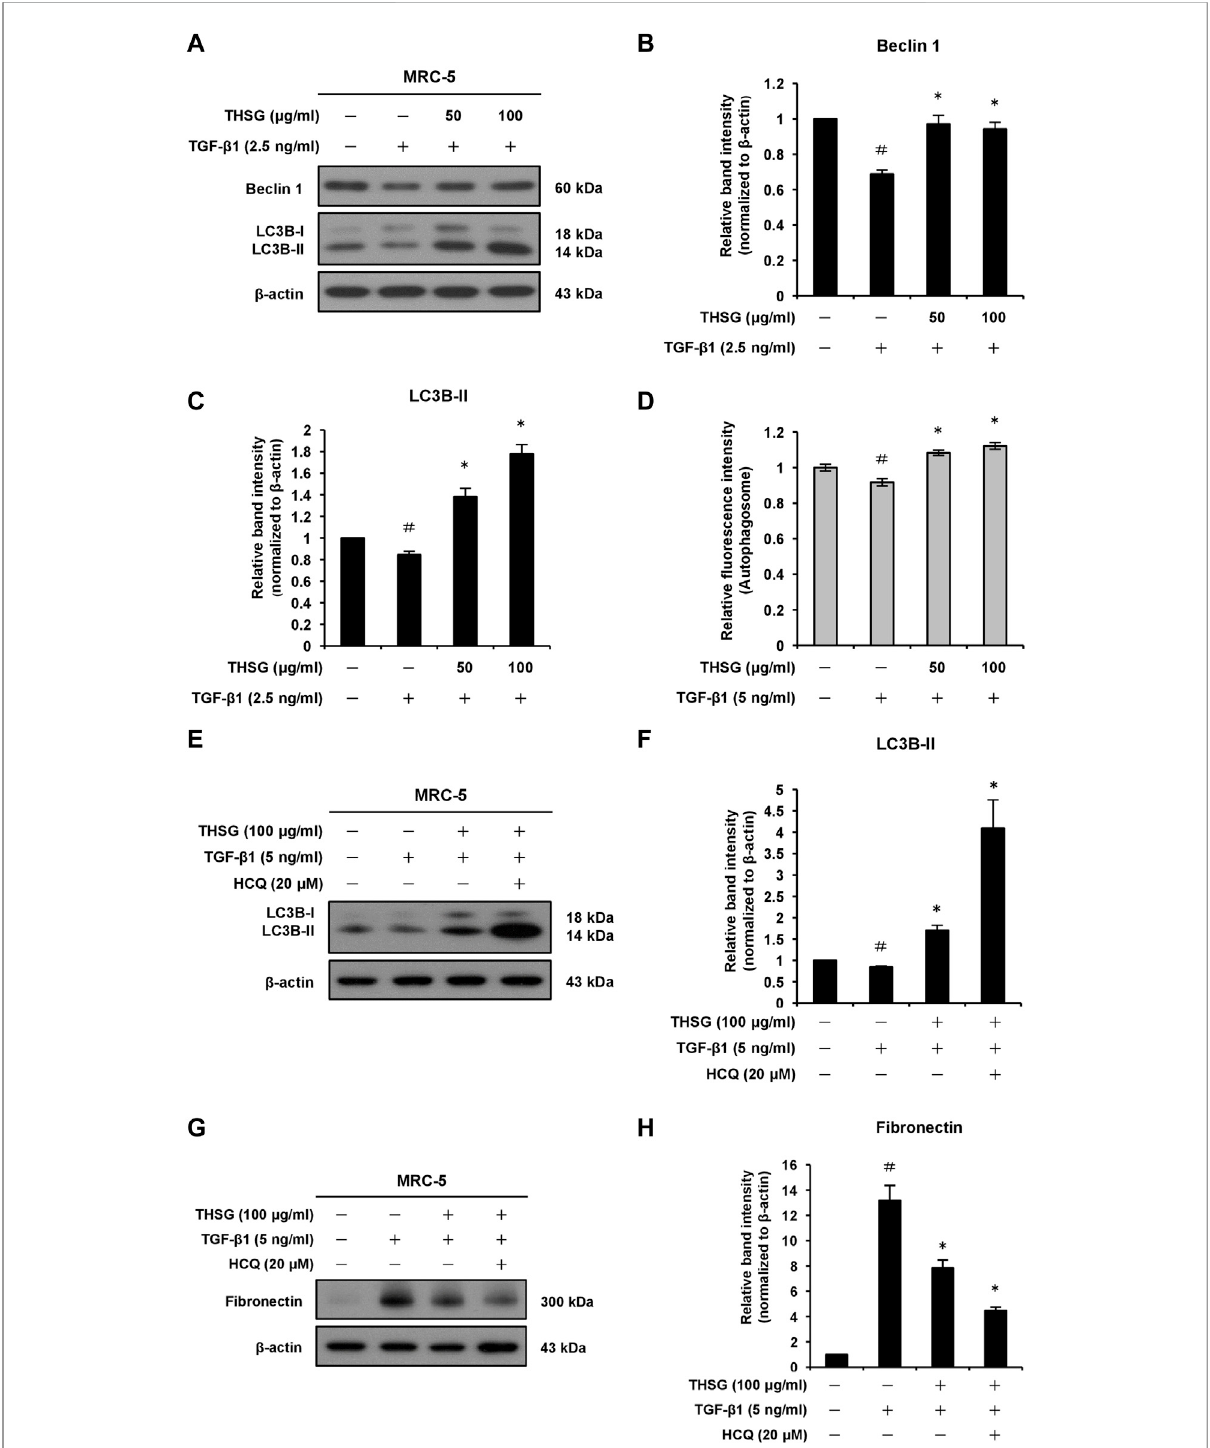
FIGURE 6 Effect of THSG on autophagy in MRC-5 cells treated with TGF- β 1. (A) The cells were serum starved for 24 h, before treatment with various concentrations (50 and 100 μ g/ml) of THSG for 24 h, and then incubated with 2.5 ng/ml of TGF- β 1 for an additional 24 h. The protein expression levels of autophagic markers Beclin 1 and LC3B in whole cell lysates were assessed by Western blotting. The β -actin was used as a loading control. The relative protein expression levels of (B) Beclin 1 and (C) LC3B-II were quanti fi ed by densitometry and normalized to β -actin. (D) After treatment with the indicated concentrations of THSG for 24 h, and autophagy in cells was measured using an autophagy assay kit. (E) Cells were